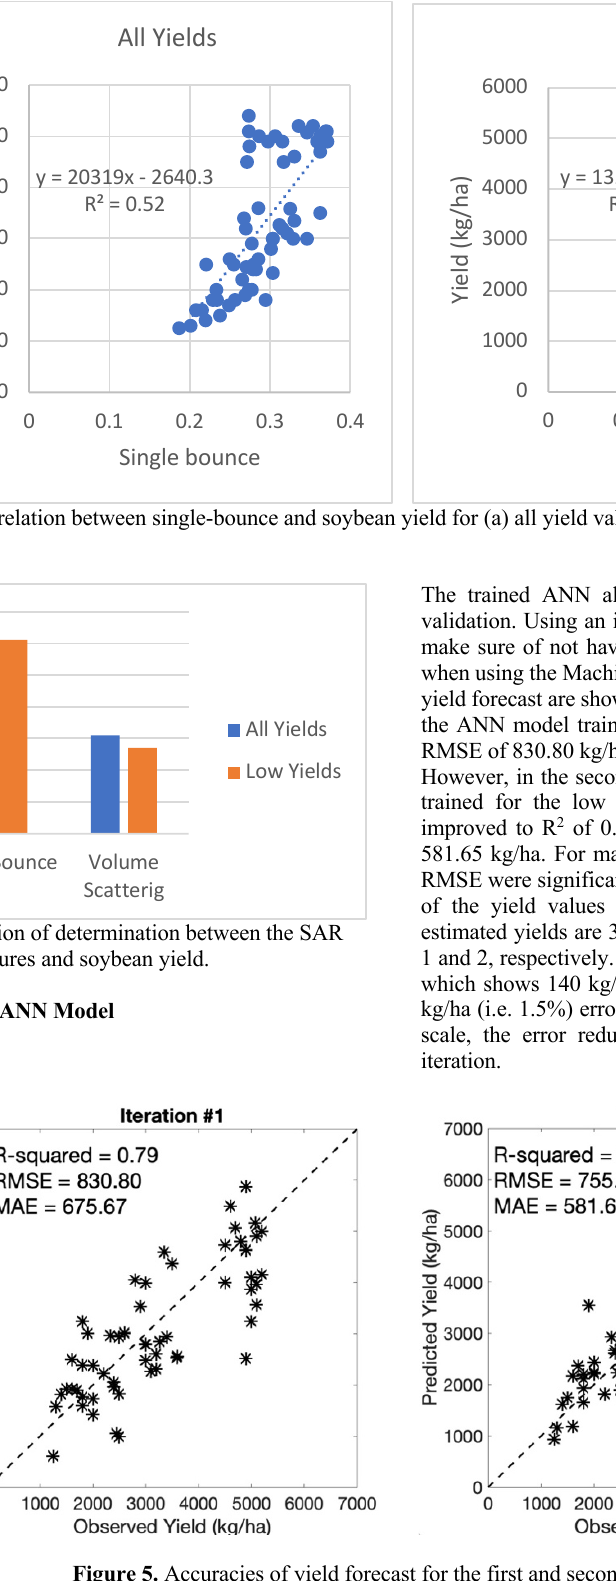
Figure 5. Accuracies of yield forecast for the first and second